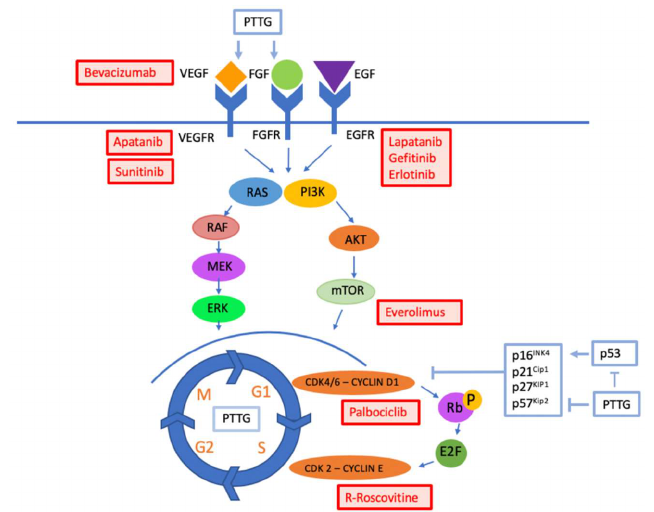
Figure 1. Growth factors, such as vascular endothelial growth factor (VEGF), epidermal growth factor (EGF) and fibroblast growth factor (FGF) bind receptor tyrosine kinases (RTKs) on the cell surface. This initiates intracellular signaling via the P13K/Akt/mTOR and Raf/Mek/ERK pathways, which promotes cell cycle progression within the cell nucleus. Cell cycle progression is activated by cyclins binding to cyclin-dependent kinases and inhibited by a number of proteins, including p16, p21, p27, p57, as well as p53, which acts by upregulating p21. Pituitary tumour transforming gene (PTTG) is an oncogene involved in multiple cellular processes, including induction of growth factors VEGF and FGF; downregulation of cell cycle inhibitors, such as p21; and modulation of cell cycle progression. Targeted therapies have been developed, which interrupt the cellular signaling pathway at different points and act to downregulate cellular differentiation and proliferation in cancer.